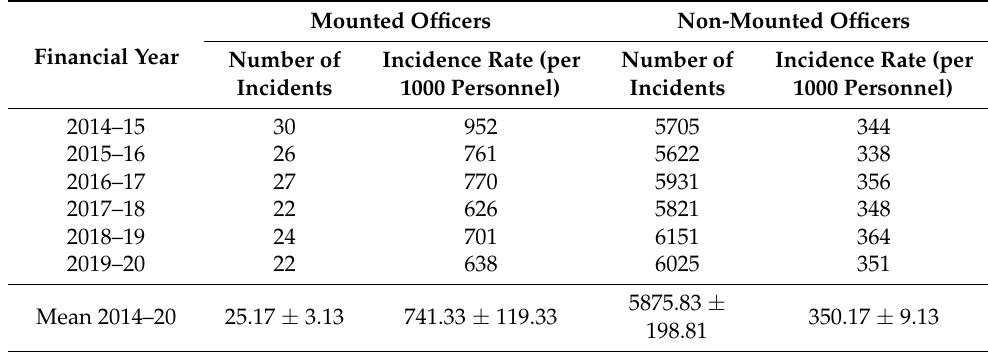
Table 1. Annual injury incidence rates by police force element and financial year.